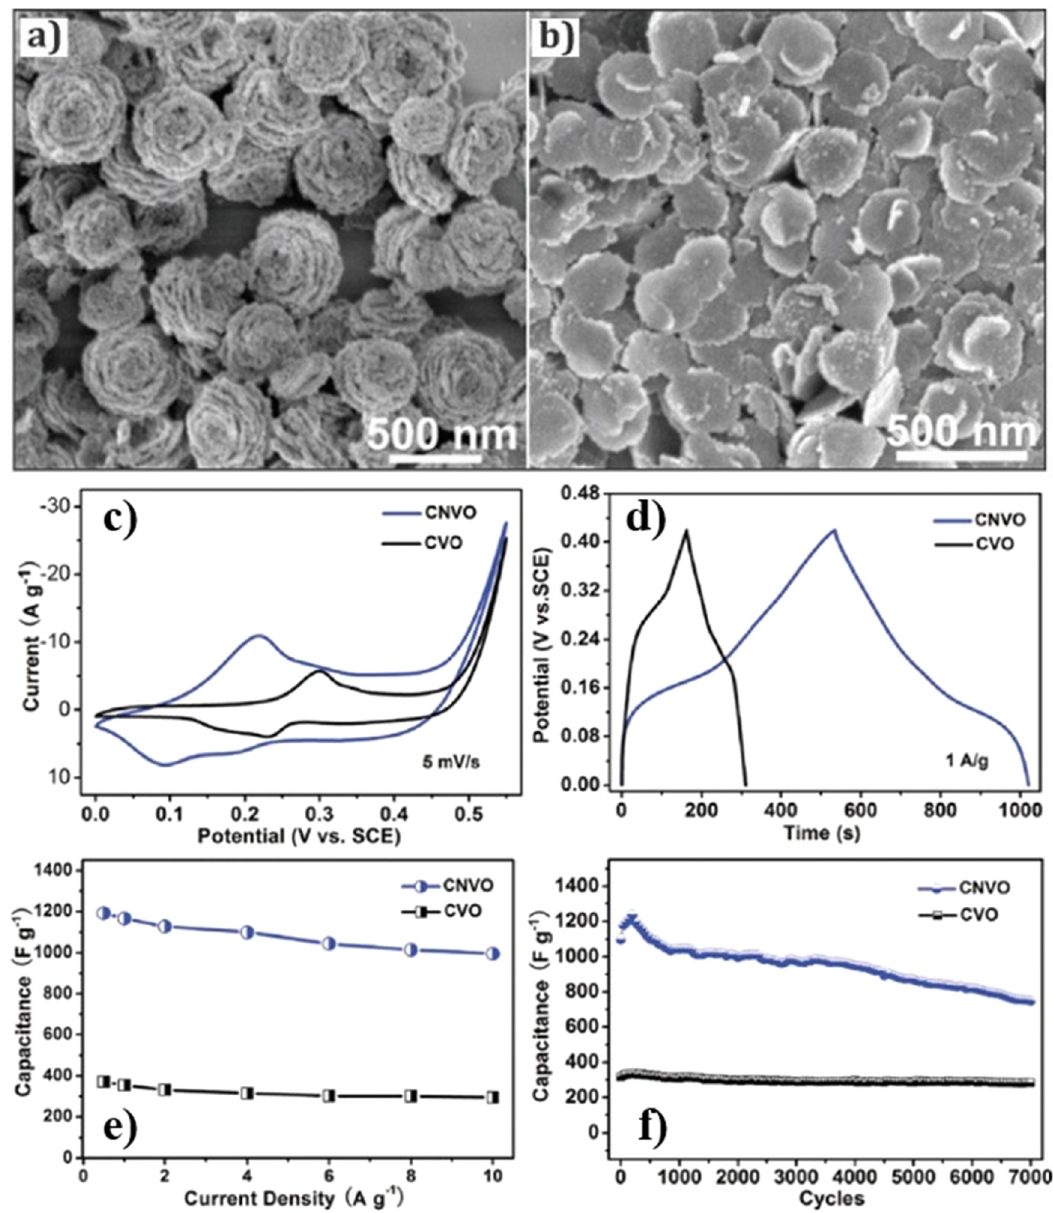
Figure 8: Scanning electron microscopy ( SEM ) image of ( a ) Co 3 V 2 O 8 ( CVO ) with nanorose structures and ( b ) NiCo 2 V 2 O 8 ( CNVO ) with nanoplate structures. Electrochemical performance characterization of porous 3D Co 3 V2O 8 nanoroses and 2D NiCo 2 V 2 O 8 nanoplates: ( c ) CV curves of Co 3 V 2 O 8 nanoroses and NiCo 2 V 2 O 8 nanoplates modi fi ed electrode at scan rate of 5 mV s − 1 . ( d ) The corresponding